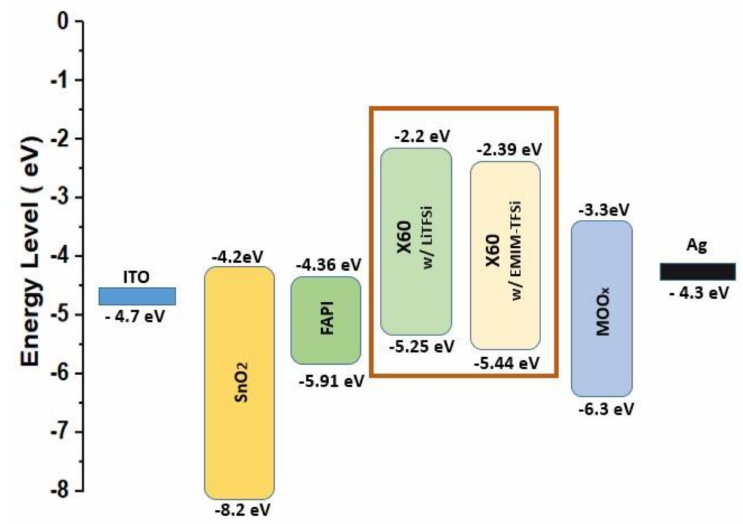
Figure 4. Energy level alignment in the device stack. In the figure are shown the energy levels of X60 doped with Li-TFSI and with EMIM-TFSI. Doping with EMIM-TFSI lowers the energy levels of